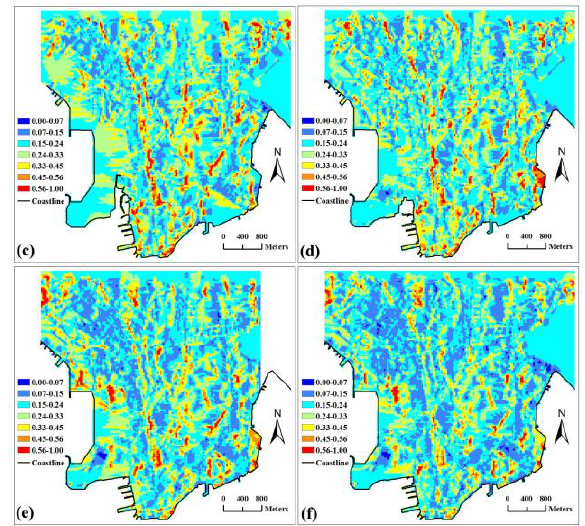
Figure 7. Spatial distribution of the normalized value of wind speed in east-west direction from 1985 to 2010. (a): 1985; (b): 1990; (c): 1995; (d): 2000; (e): 2005; (f): 2010